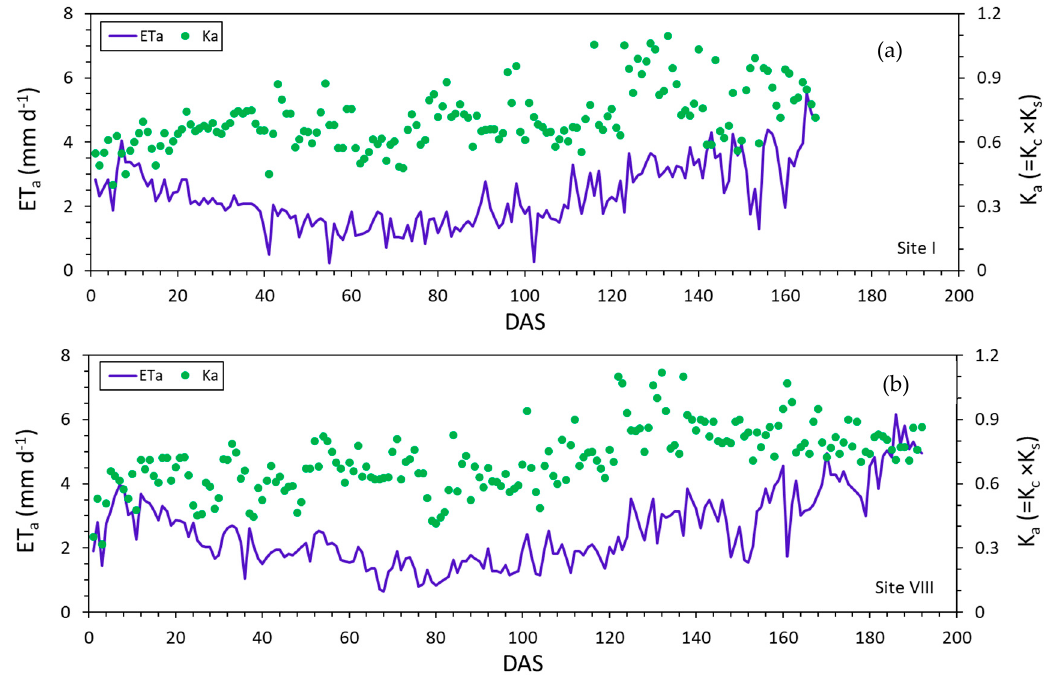
Figure 7. Daily actual evapotranspiration (ET a ) and daily actual crop coefficient (K a ) at Sites I ( a ) and VIII ( b ). The daily stress coefficient (K s ) represents water and salt stresses, management, and environmental multipliers. To obtain the actual ET, K s is needed to adjust the crop coefficient (K c